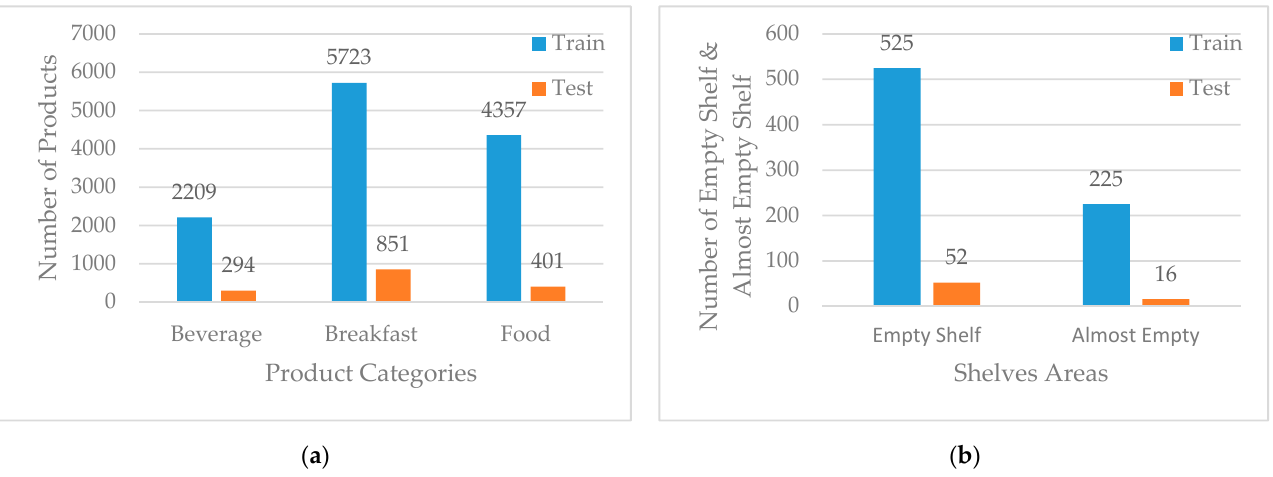
Figure 7. ( a ) Distribution of labeled products; ( b ) Distribution of labeled shelves’ areas.